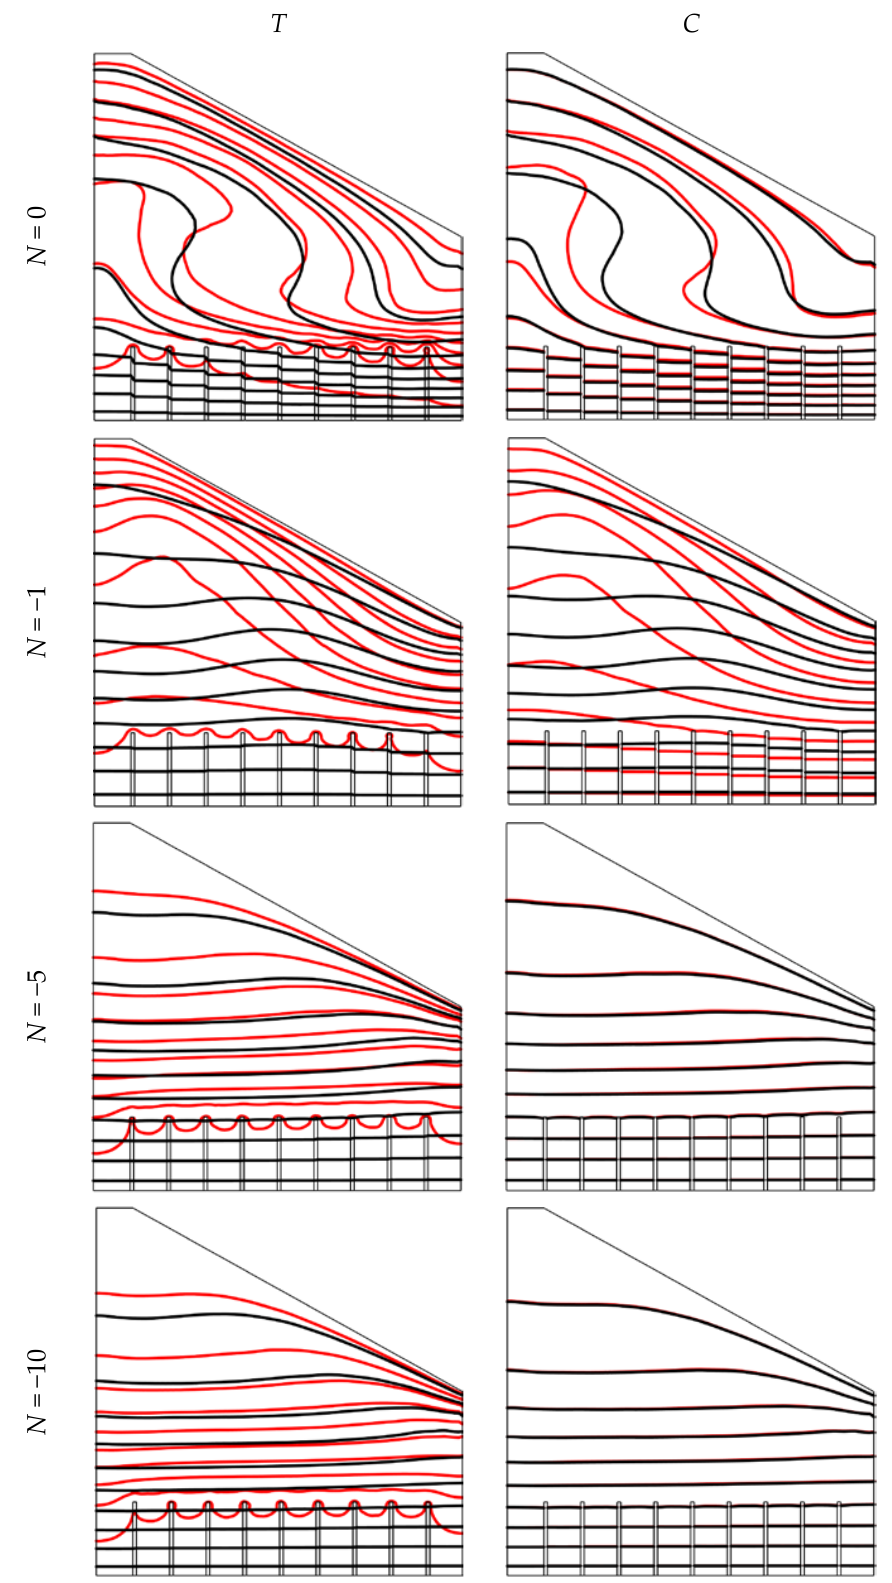
Figure 8. Effect of the buoyancy and conductivity ratios on the isotherms and iso-concentrations at the central plan for Ra = 10 5 ; Red ( Rc = 100) and Black ( Rc = 0.01).